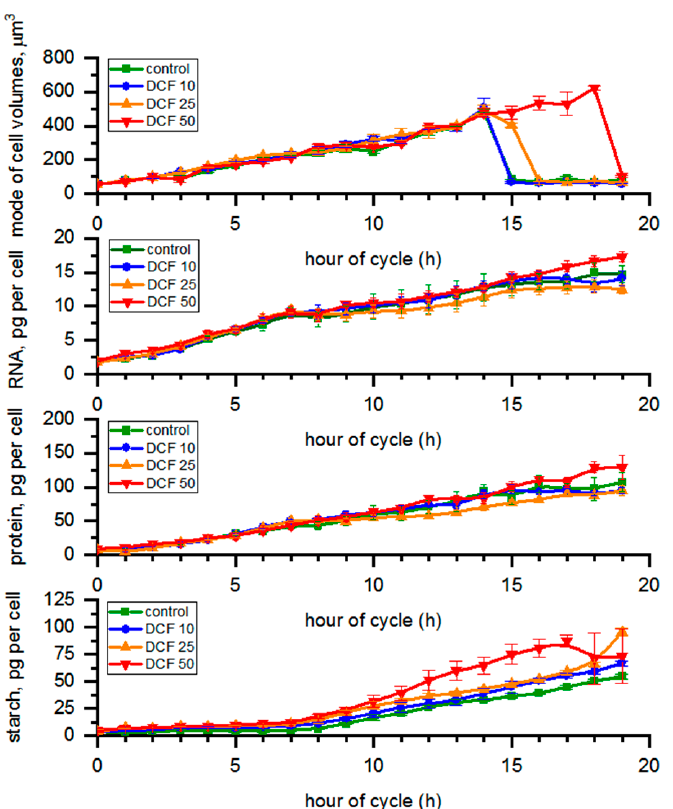
Figure 1. Cell volume, RNA, protein, and starch content calculated per single mother cell. Data are presented as means ± SE. The mode cell volume and starch content of DCF50 were statistically significantly different from controls (correlation comparison, p < 0.05, n = 3). Data are presented as pg per mother cells even at the time of cell division to allow simple comparison across the